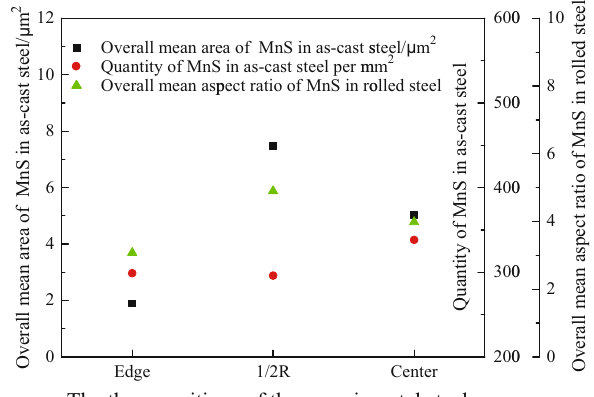
Figure 4: The statistical analysis of MnS at different positions of the experimental